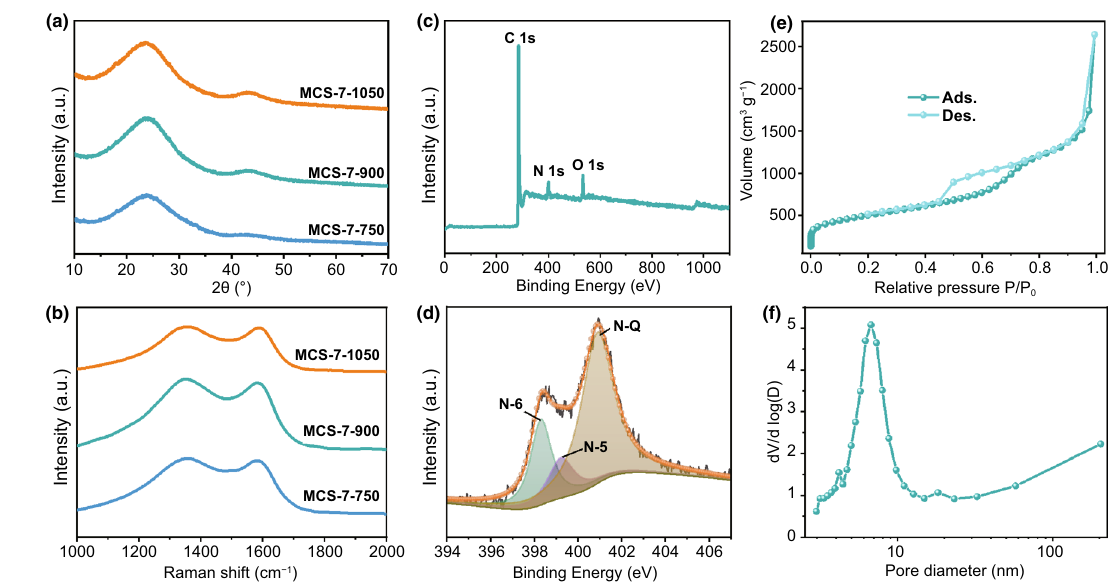
Fig. 2 a, b XRD patterns and Raman spectra of MCS-7 calcined at 750, 900, and 1050 °C, respectively. c, d XPS survey spectrum and High- resolution N 1 s spectrum of MCS-7-900. e, f N 2 adsorption–desorption isotherms as well as pore size distribution of